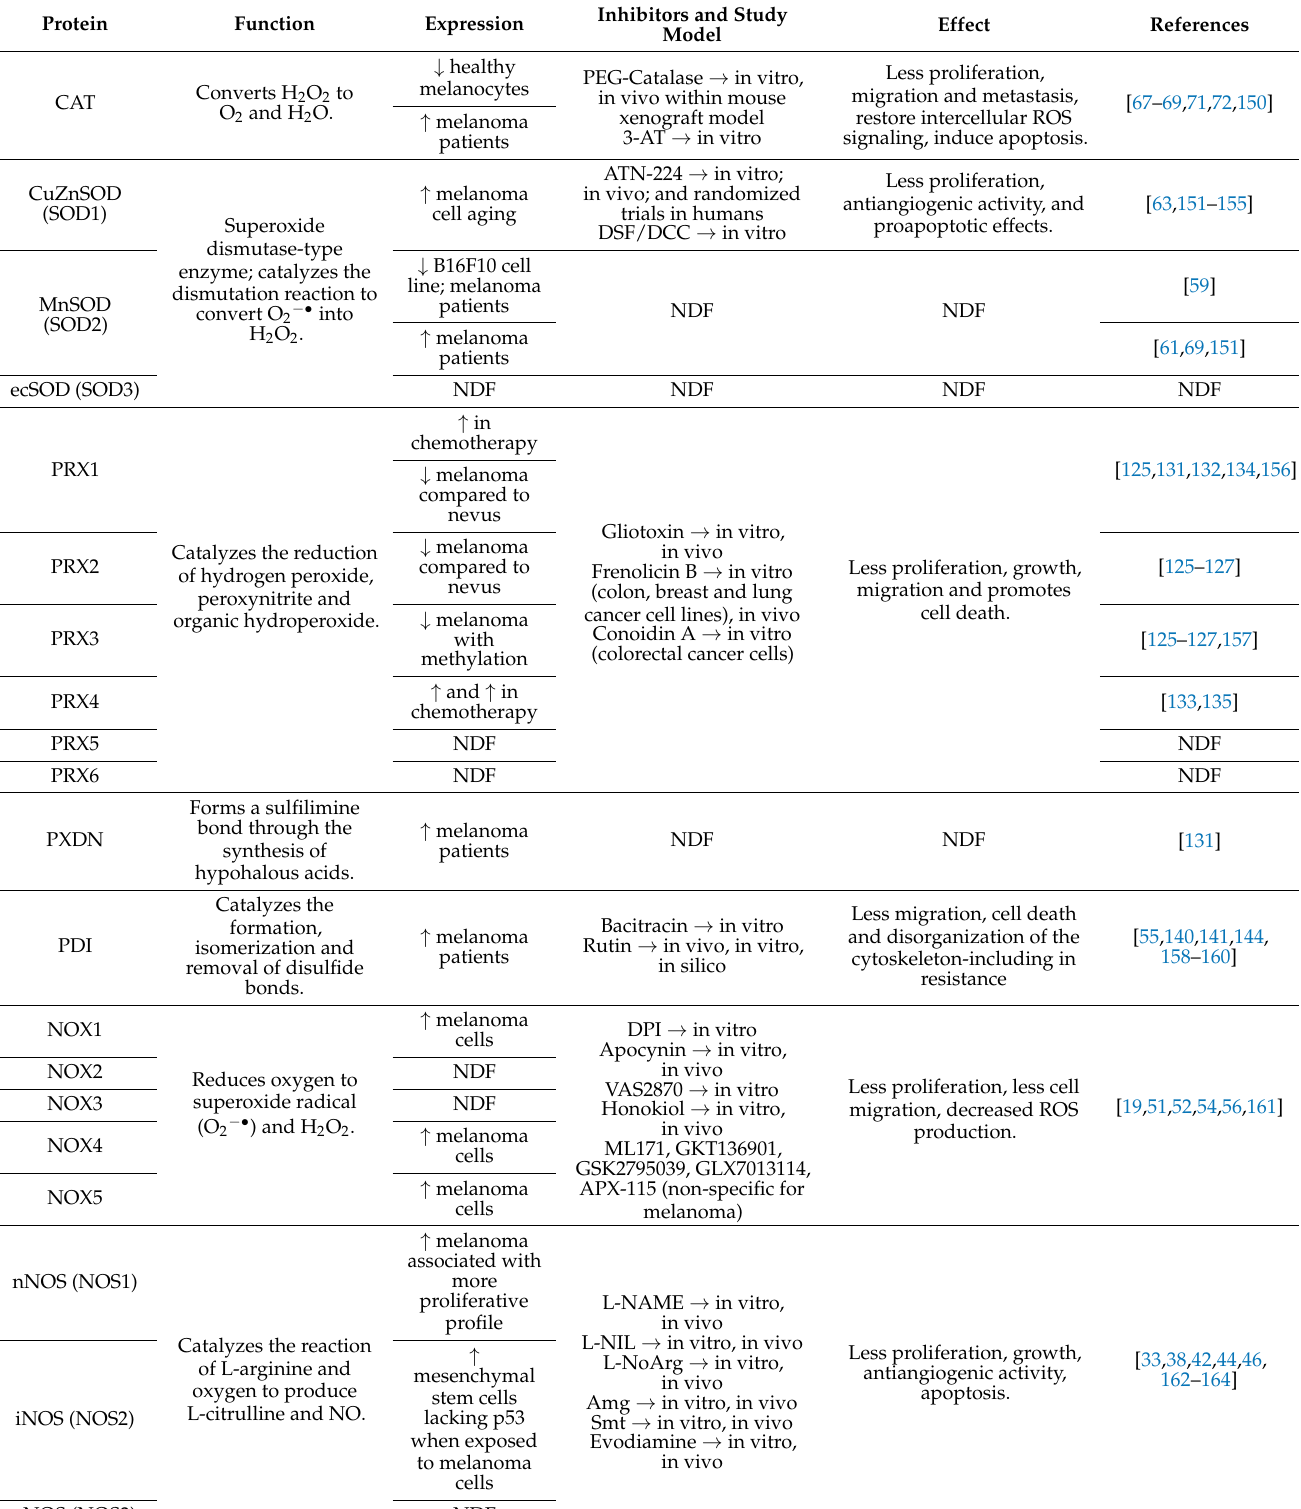
Table 1. Expression of redox sensitive proteins in melanoma. NDF: no data